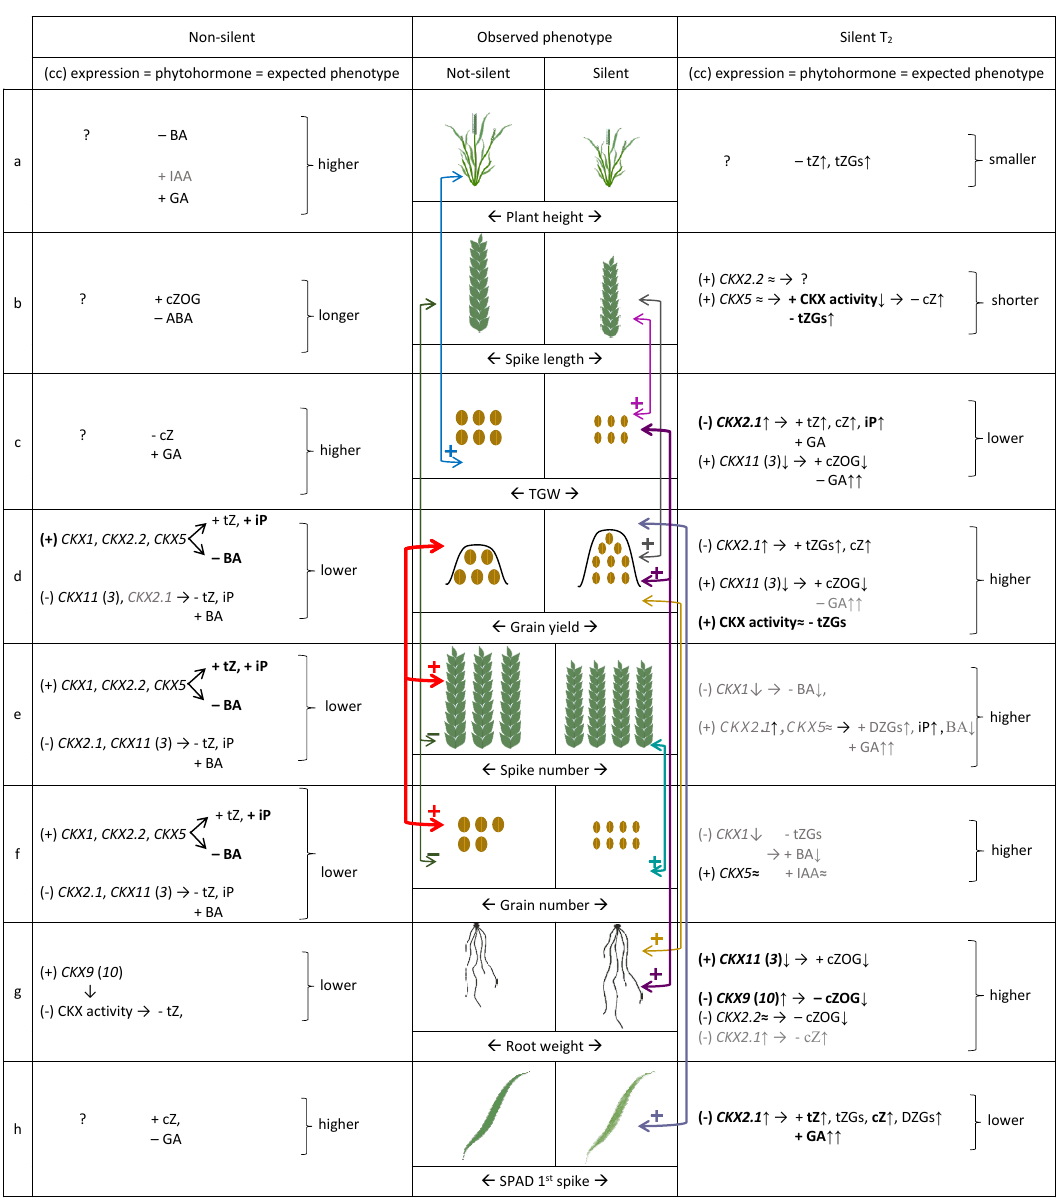
Figure 6. Models of regulation of phytohormone levels and phenotypic traits by coordinated expression of TaCKX genes based on correlation coefficients (cc) in non-silenced and silenced wheat plants ( a – h ). (cc)—correlation coefficient between expression and trait; (?) – lack of correlation with expression of any gene; bold—strong, significant correlations at p ≤ 0.05 (cc above 0.82); grey—cc from 0.5 to 0.6.